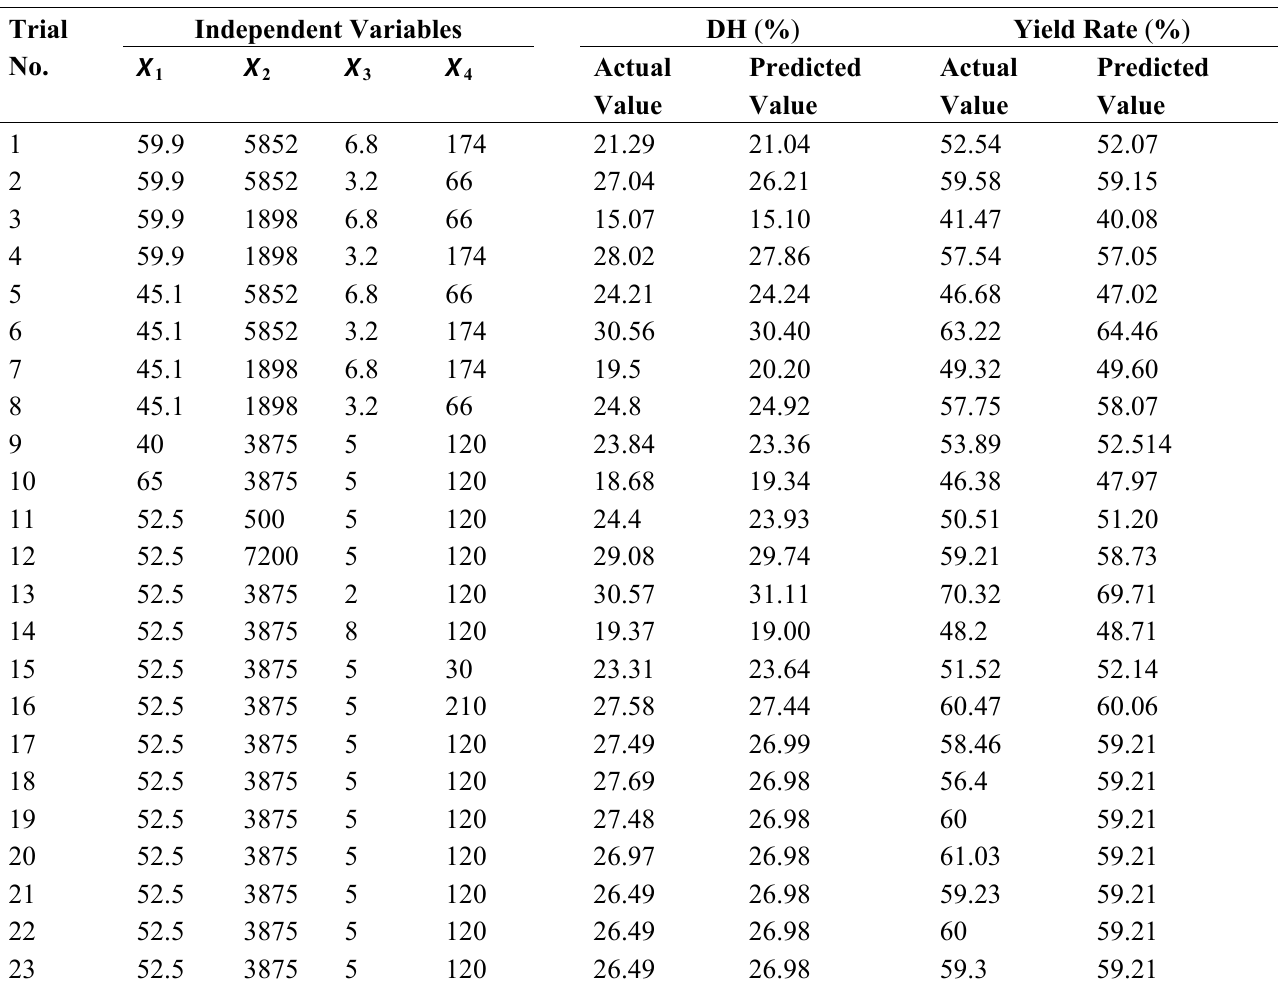
) were the four independent 4